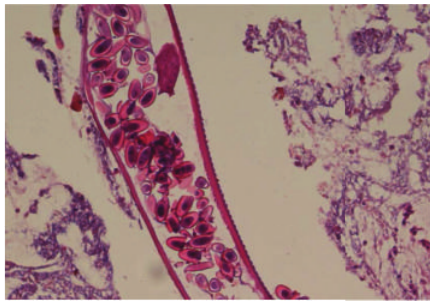
Figure 5: Longitudinal section through the larval stage of a female pinworm with numerous